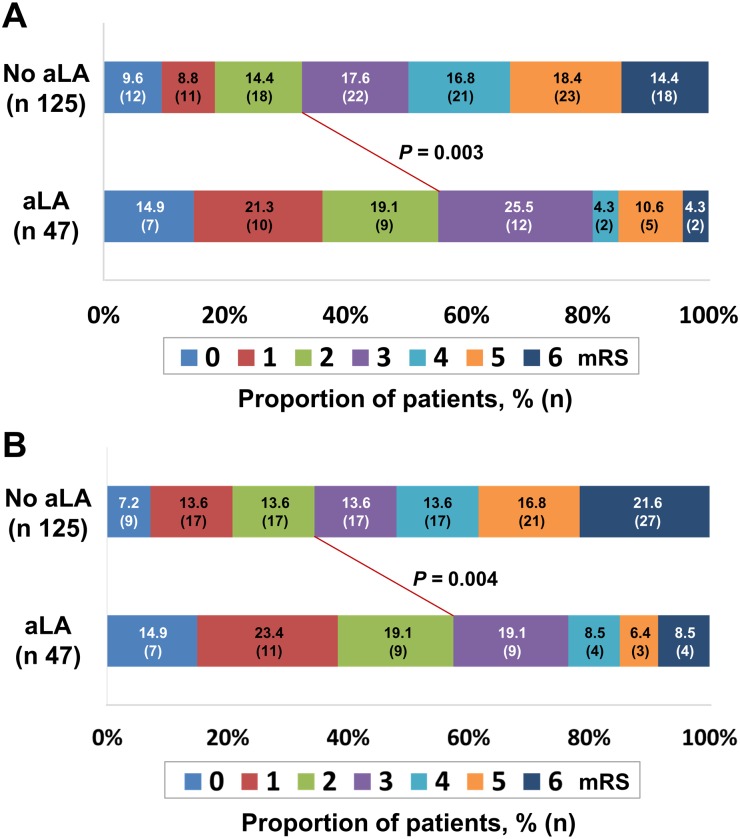
Distribution of the modified Rankin Scale (mRS) scores among patients classified based on the use of alpha-lipoic acid (aLA) 3 months (A) and 1 year (B) after ischemic stroke.The lines indicate differences in mRS categories (mRS scores of 0–2 vs. 3–6) between groups classified by aLA use. The p-value refers to the significance level of the chi-square test used to compare proportions.